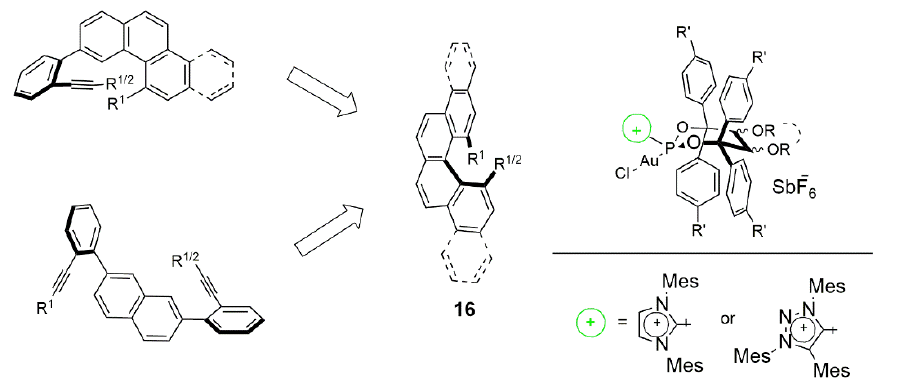
Figure 9. Synthetic approaches to the enantioselective synthesis of 1,12-disubstituted [4]helicene ( 16 ).